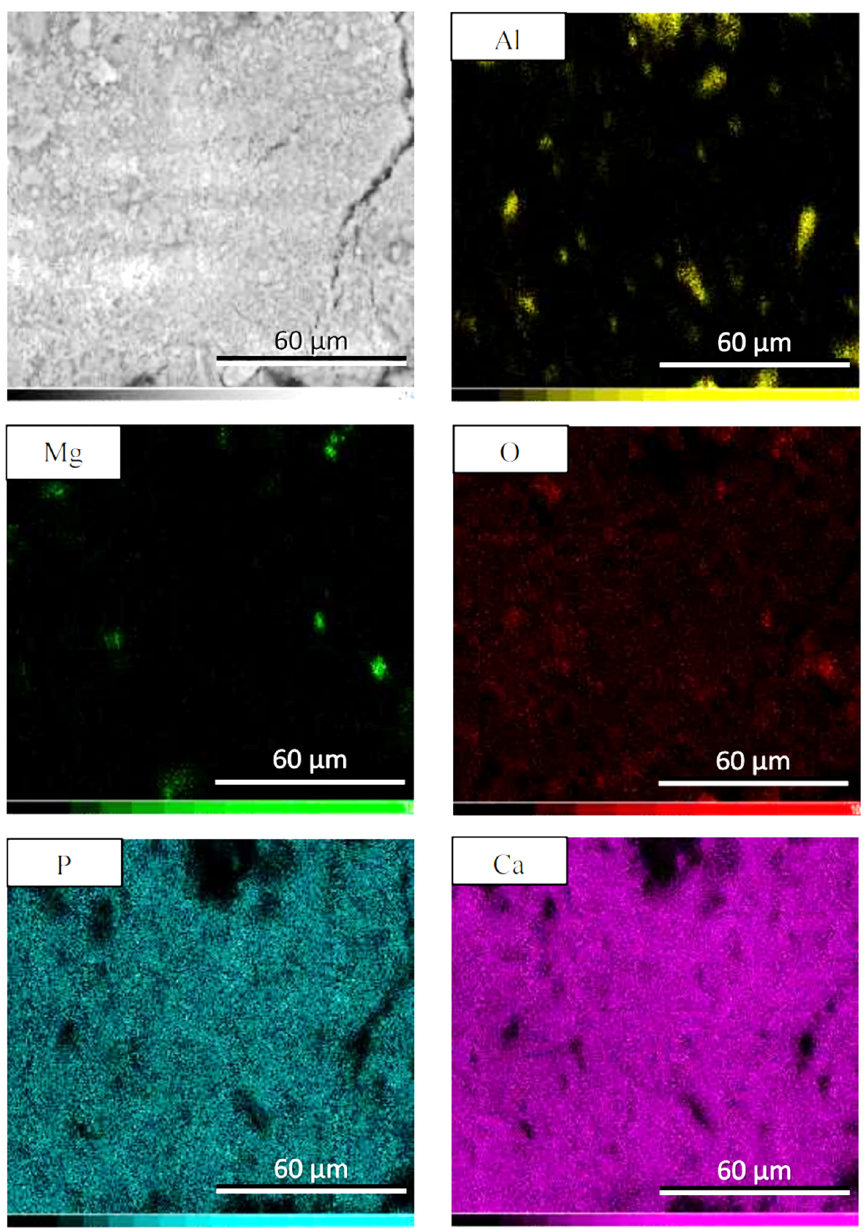
Figure 7. SEM-EDS pictures of the hydroxyapatite composite made by Al size-fraction of >150 µ m with compaction pressure of 100 MPa. Table 4. Elemental composition derived from the EDS measurements of the hydroxyapatite compo-